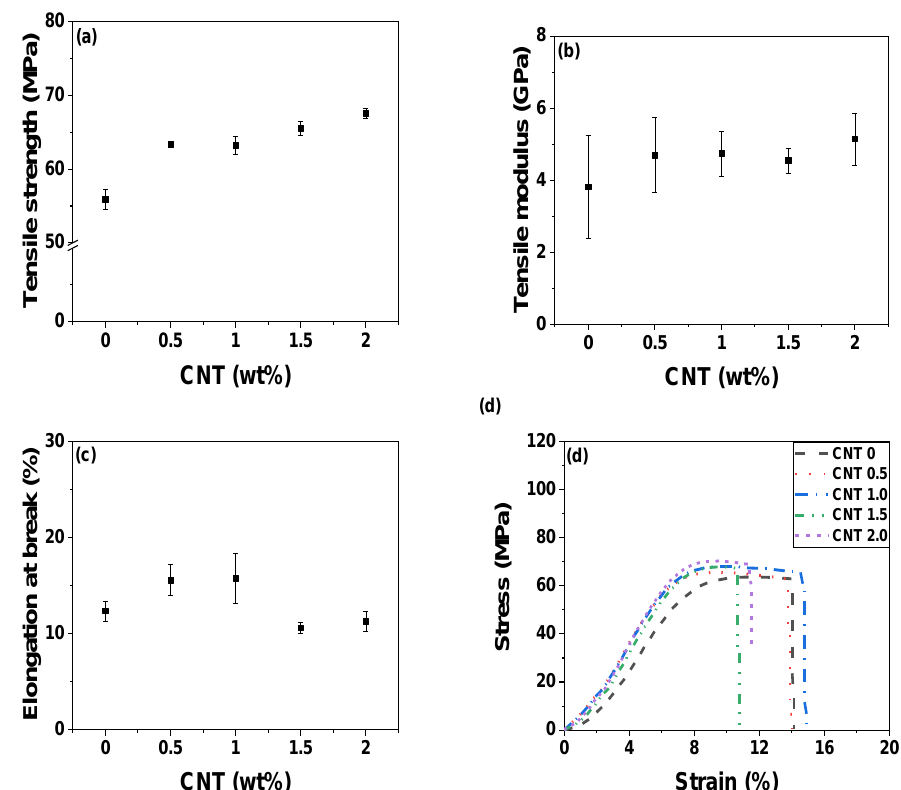
Figure 3. Tensile properties of POM/CNT nanocomposites: ( a ) ultimate tensile strength; ( b ) Young’s modulus; ( c ) elongation at break; ( d ) stress – strain curves.